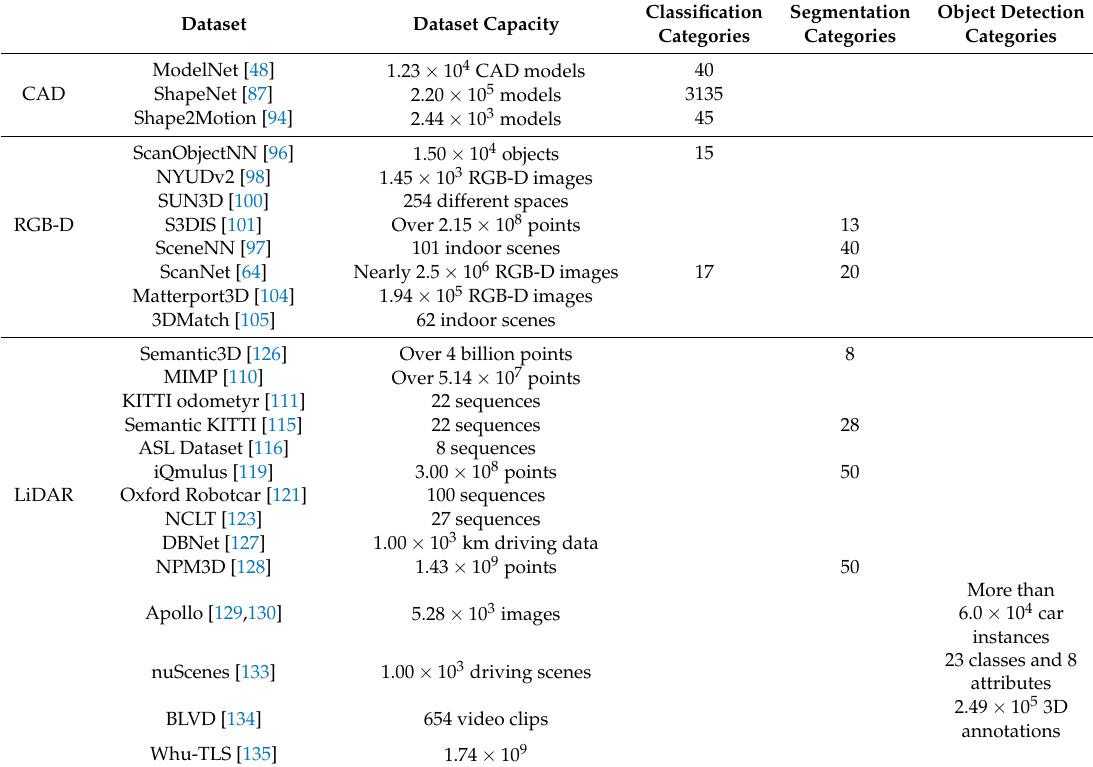
Table 3. Details of benchmark